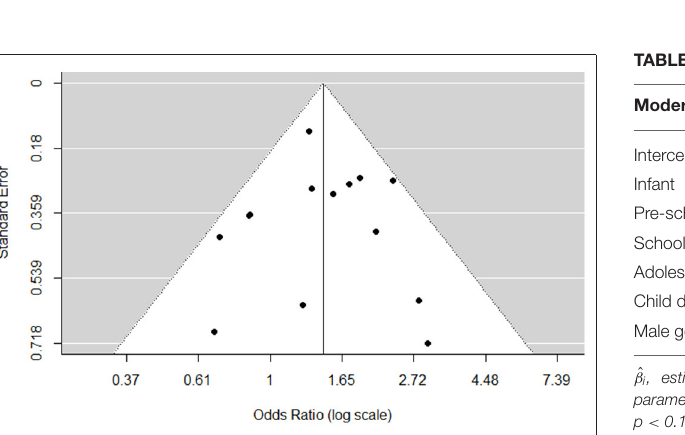
(infants: ˆ β i = 0.40,Q Model = 12.36, df = 2, p = 0.0021; pre- schoolers: ˆ β i = 0.36, Q Model = 12.23, df = 2, p = 0.0022; school- age children: ˆ β i = 0.36, Q Model = 12.25, df = 2, p = 0.0022;